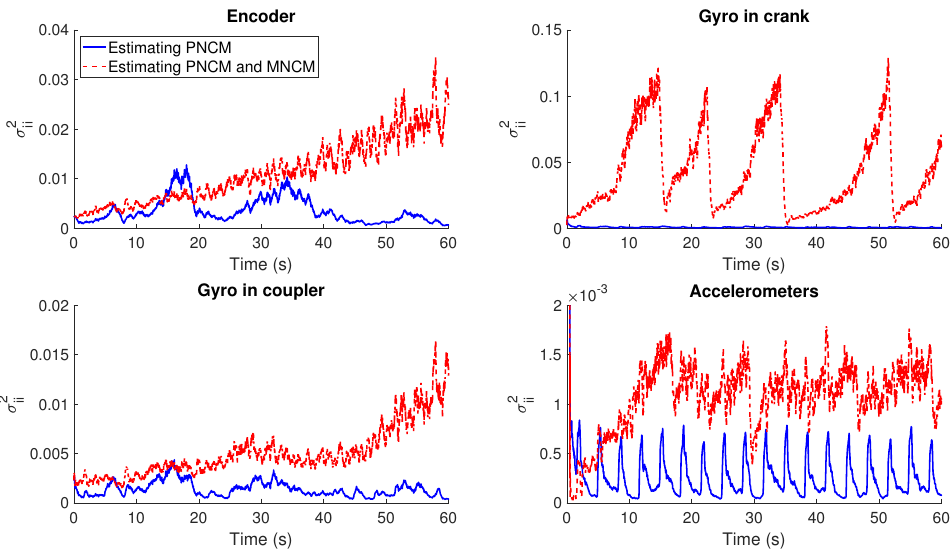
Figure 4. Estimated PNCM element in the four-bar linkage test for the case of estimating PNCM and MNCM simultaneously and estimating only the PNCM.